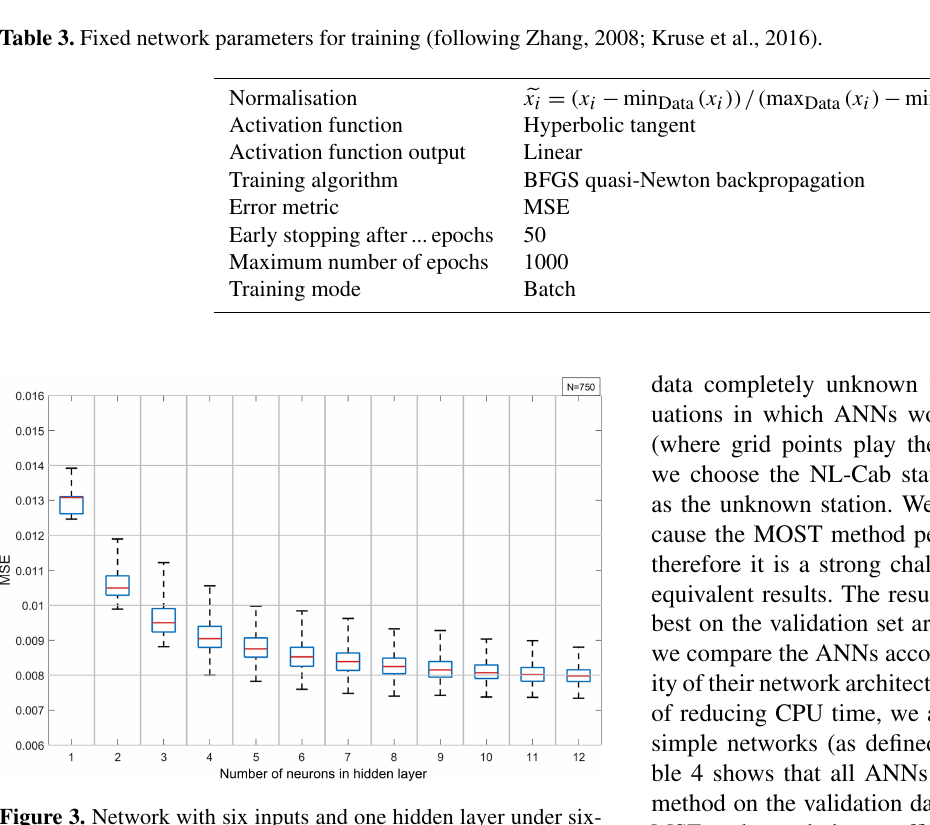
Figure 3. Network with six inputs and one hidden layer under six- fold cross-validation: the MSE of the network trained on the valida- tion data set using random data splitting as a function of the hidden layer size. Whiskers indicate the interquartile range, and each box summarises the results from 750 single